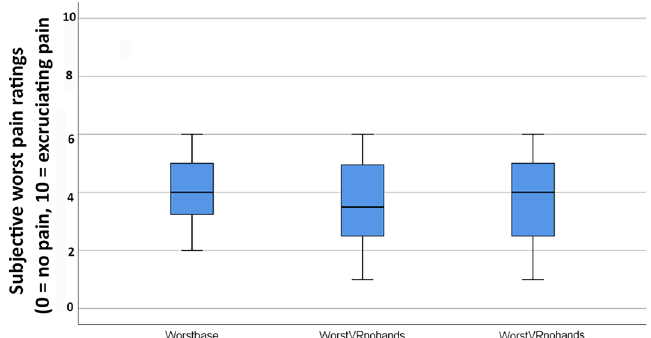
Figure 8. Phase 1. On an n = 12 side study to test important assumptions of my thermal pain paradigm, consistent with my assumptions, as predicted, no significant differences were found between No VR, passive VR on Test 1 vs. passive VR again on Test 2 reducing pain intensity (worst pain